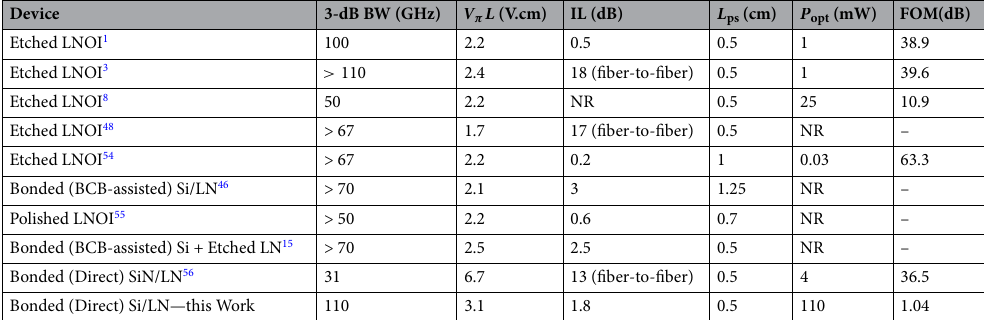
Table 1. Comparison of recent TFLN-based MZM performance metrics NR: Not Reported. IL (dB): on-chip Insertion Loss in dB; fiber-to-fiber Insertion Loss in dB is reported where noted. FOM (dB) is defined